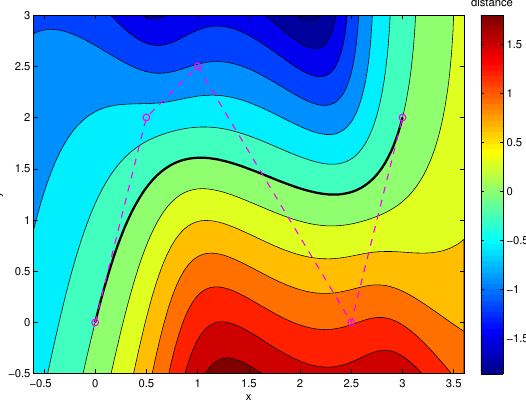
Figure 3. Implicitization of a quartic Bézier curve. Level set Γ ( x ) = det ( M ( x )) can be used as a measure of